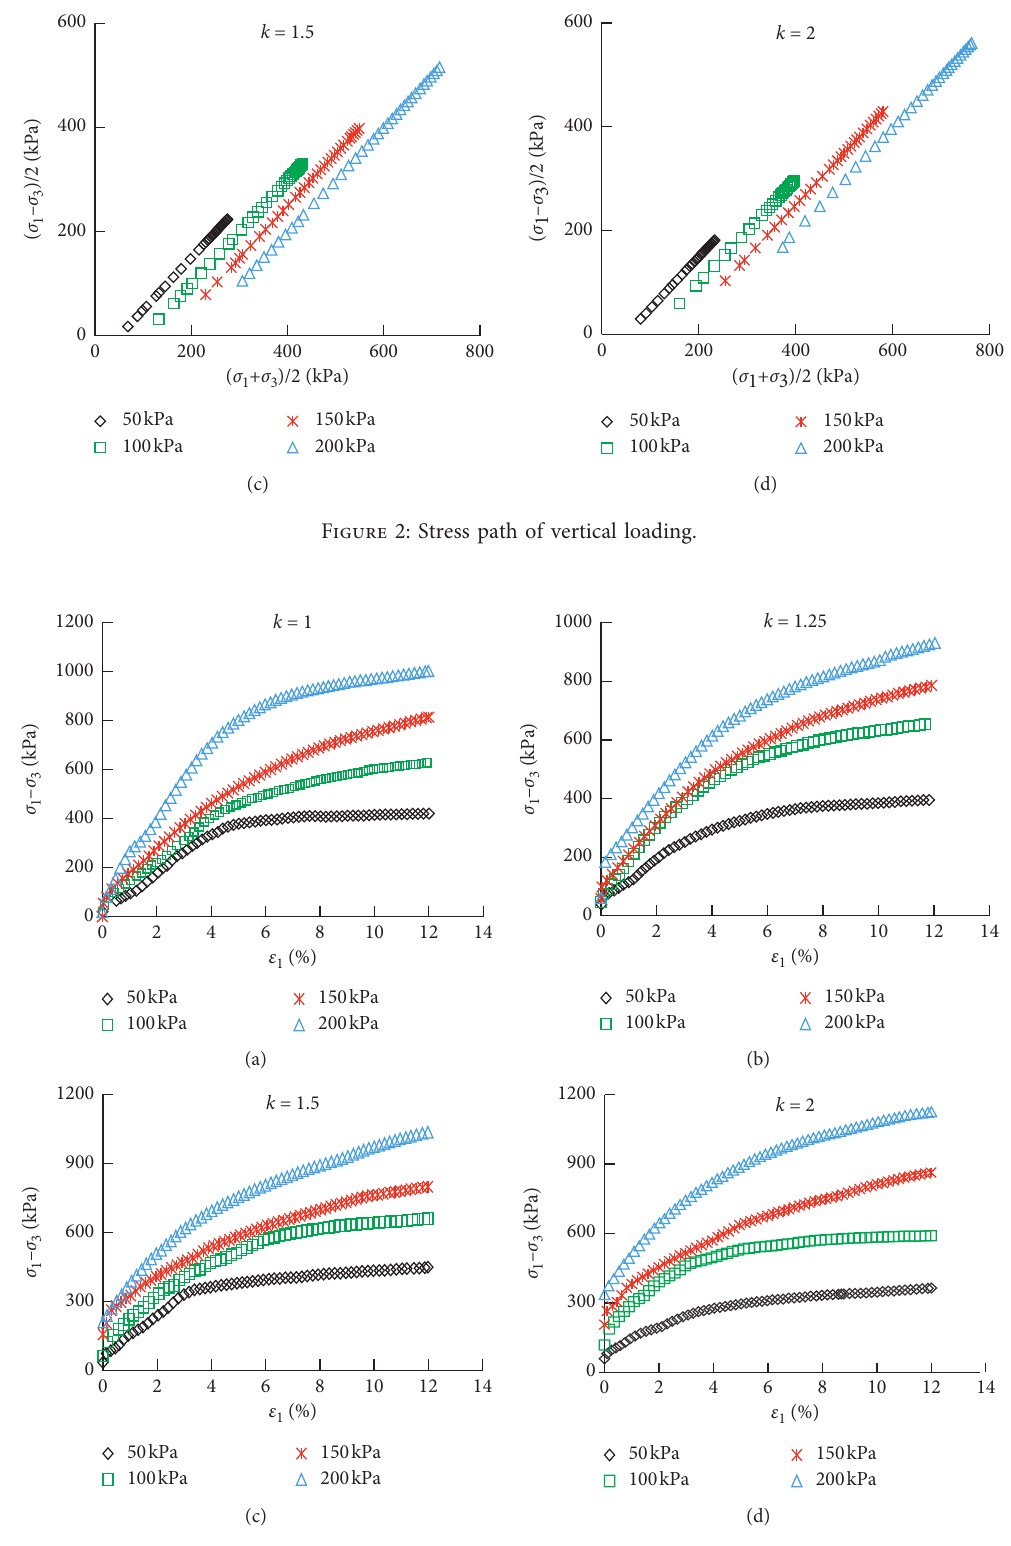
Figure 3: Stress-strain curves of intact loess at different k values.